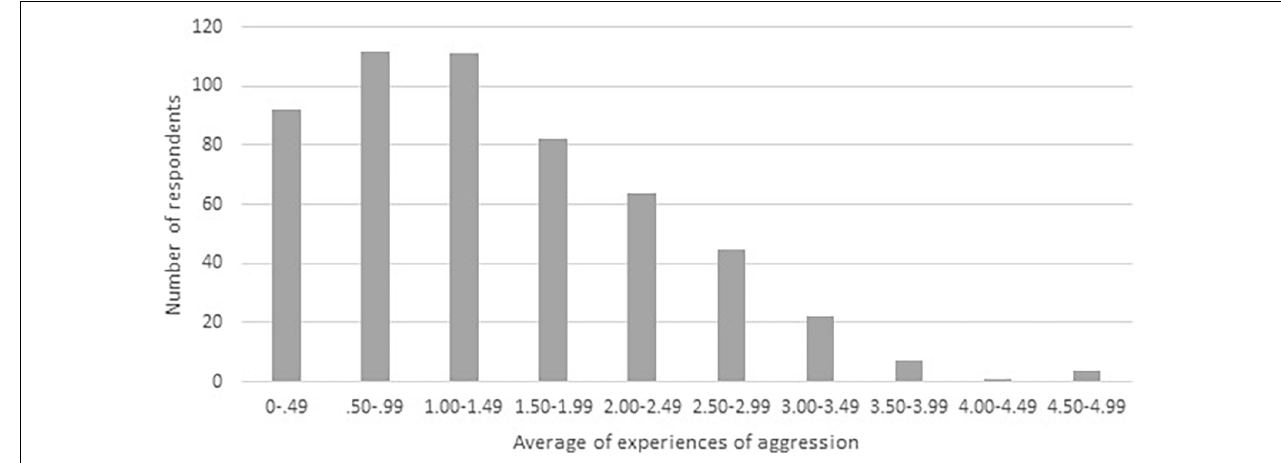
FIGURE 1 | Distribution of experiences of aggression (measured on a scale from 0 to 6) of police officers ( N = 540).